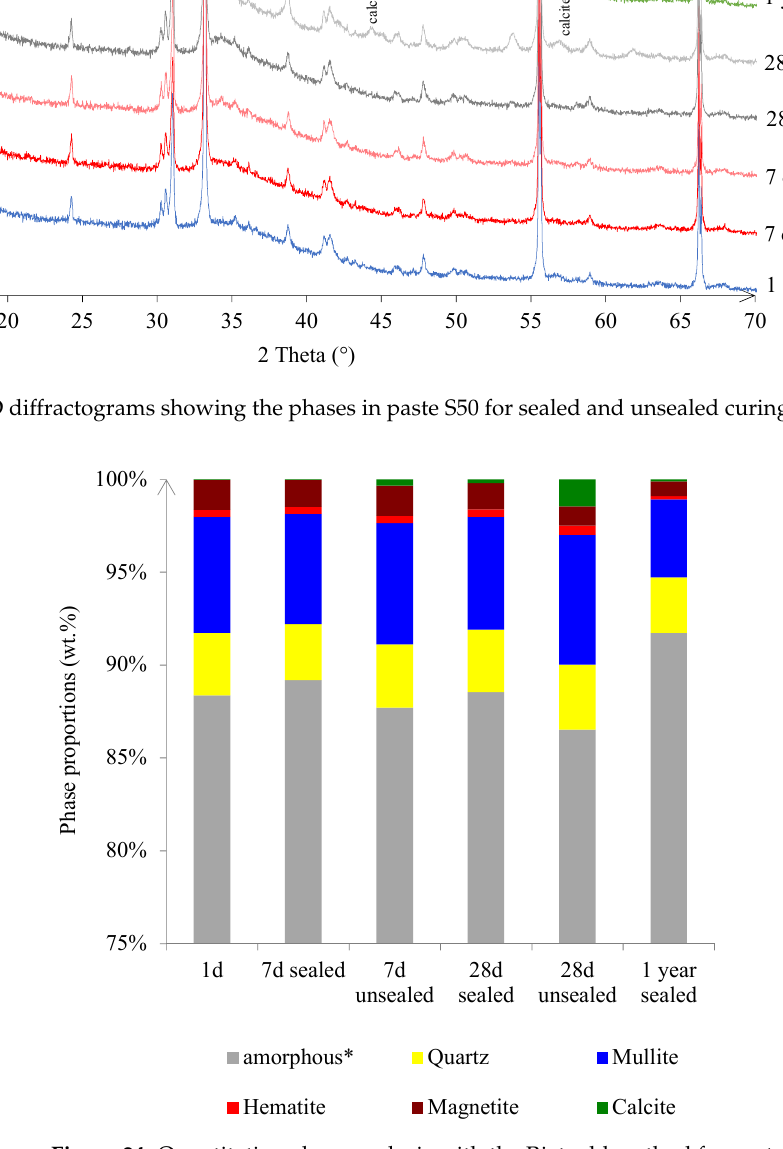
Figure 24. Quantitative phase analysis with the Rietveld method for paste S50 as a function of time and curing conditions. * stands for proportion of amorphous phase when excluding the internal standard in QXRD calculations.